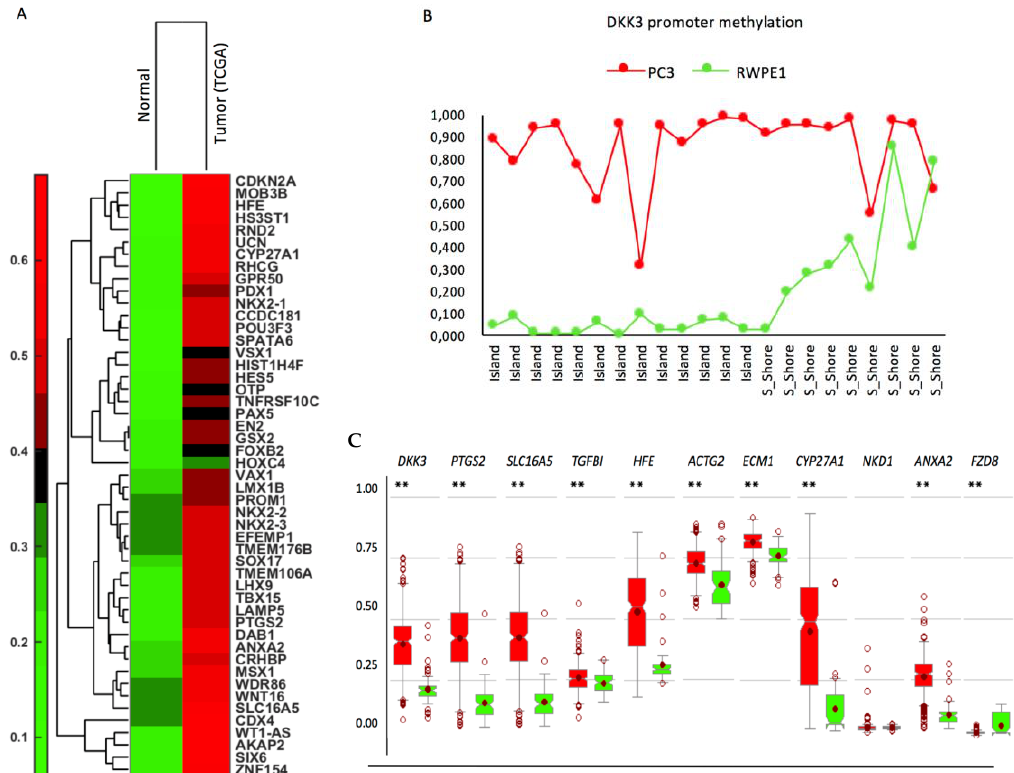
Figure 6. Hypermethylation of the DKK3 promoter region ( A ) Dendrogram of two-dimensional hierarchical clustering analysis of 49 genes that are more highly methylated in tumor samples than in normal prostate, selected by comparison of average promoter methylation (beta-values) in multiple studies of prostate. ( B ) Average methylation (beta-values) of DKK3 promoter region in PC3 and RWPE1 cells from GEO (GSM1323600 and GSM1323601, respectively). ( C ) Methylation status (percentage) in the CpG sites of the promoter regions for the indicated genes in normal prostate and prostate cancer, extracted from the TGCA dataset using the MethHC database.